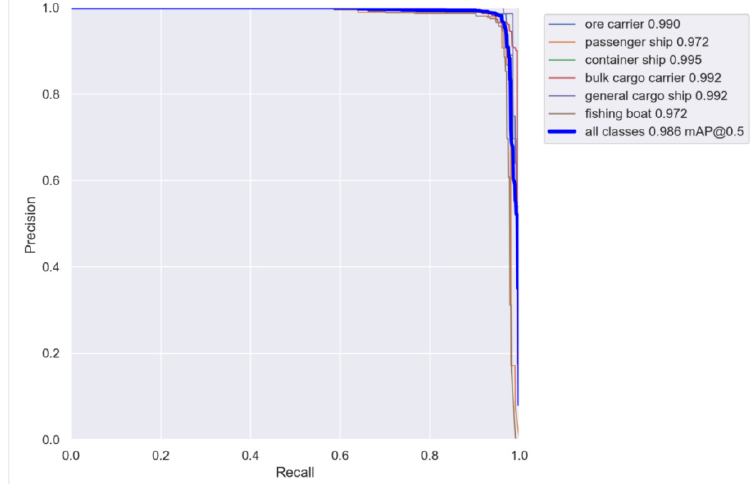
Figure 9. PR curve of YOLOv5s.